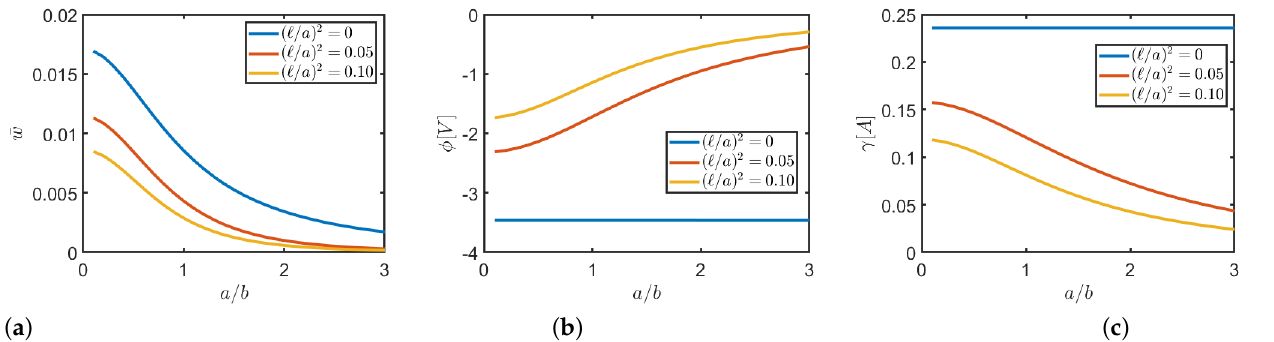
Figure 4. Graphs of displacement ¯ w ( a ) electric φ ( b ) and magnetic γ ( c ) potential, in the point ( a /2, b /2 ) to vary of a / b ratio and for different values of nonlocal parameter ( (cid:96) / a ) 2 and for n p = 1. (SDL; q = 0 N/m 2 , T 0 = 0 K, T 1 = 1 K, ρ E = 0 C/m 2 , ρ H = 0 Wb/m 2 )